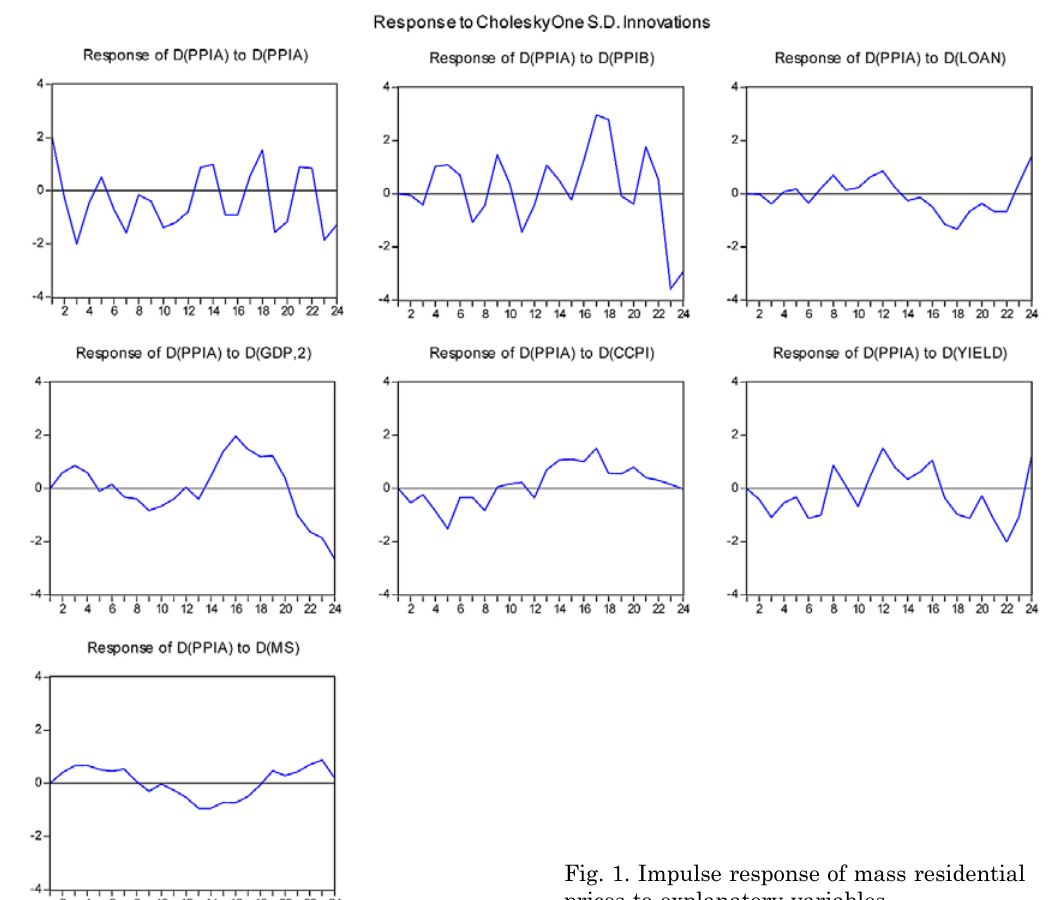
Fig. 1. Impulse response of mass residential prices to explanatory